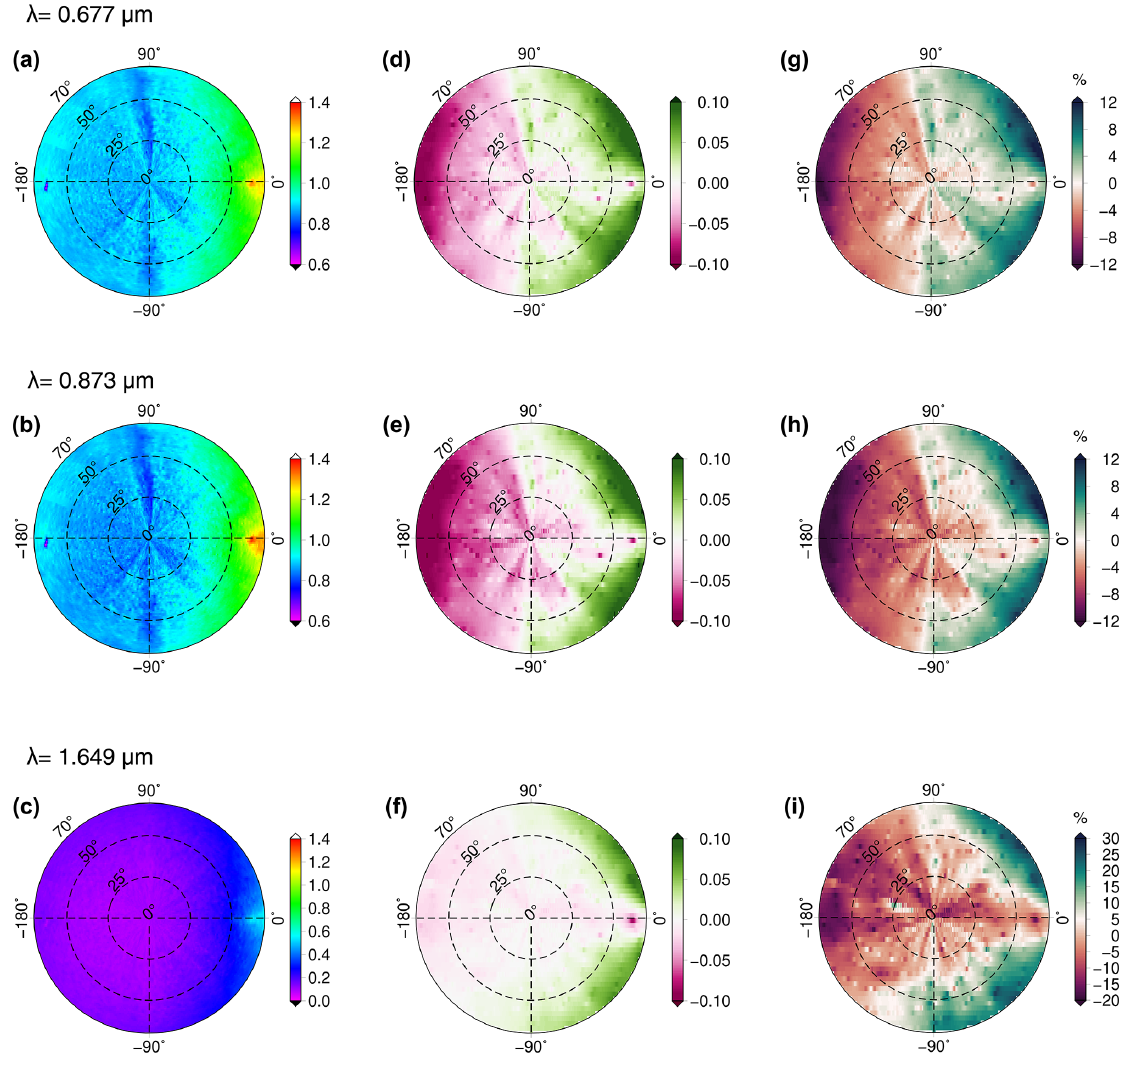
Figure 10. The same as Fig. 9 but the measurements by the CAR instrument were performed on 15 April 2008 at 181m flight altitude over fresh